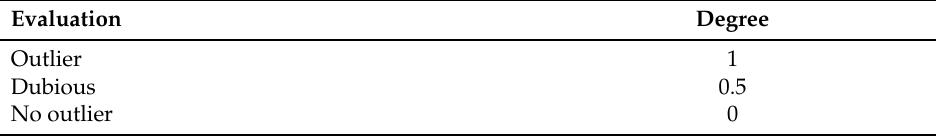
Table 4. Evaluation table for an